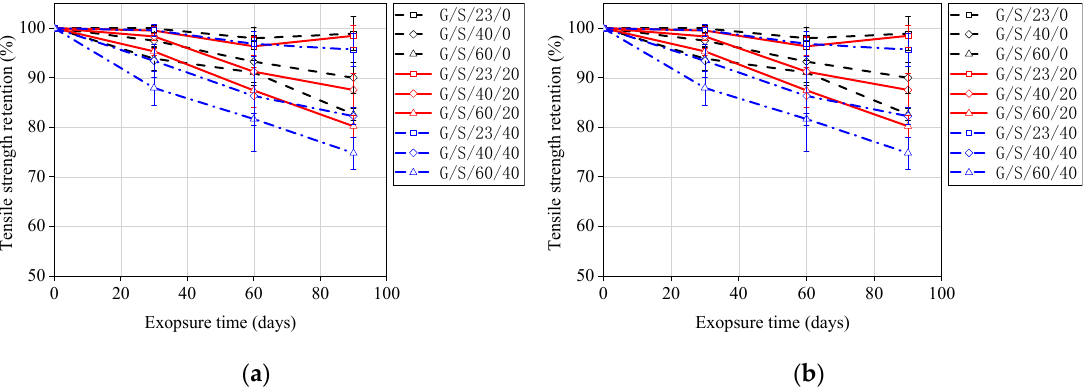
Figure 4. Tensile strength retention of GFRP bars exposed to ( a ) seawater solution and ( b ) concrete pore solution.